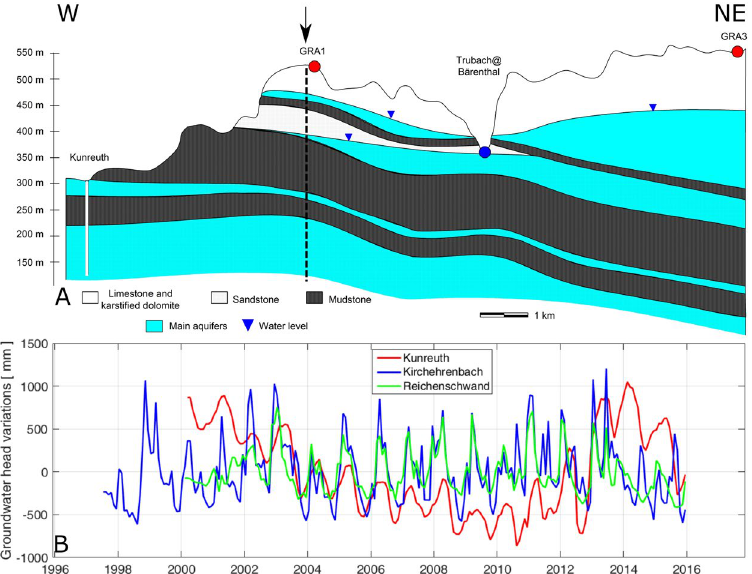
Figure 2. ( A ) Hydrogeological W-E cross-section (adapted from Krüger 1994 32 ) illustrating the complexity of the aquifers under the Gräfenberg array (stations GRA1 and GRA3 are shown), locations of example piezometric levels (triangles) and the Bärenthal discharge station (circle) in the area. The arrow indicates where the profile changes orientation (see Fig. 1). ( B ) Groundwater head variations for the three piezometers in the area (http:// www.gkd.bayern.de): Kunreuth (1 on the map in Fig. 1), Kirchehrenbach (2) and Reichenschwand